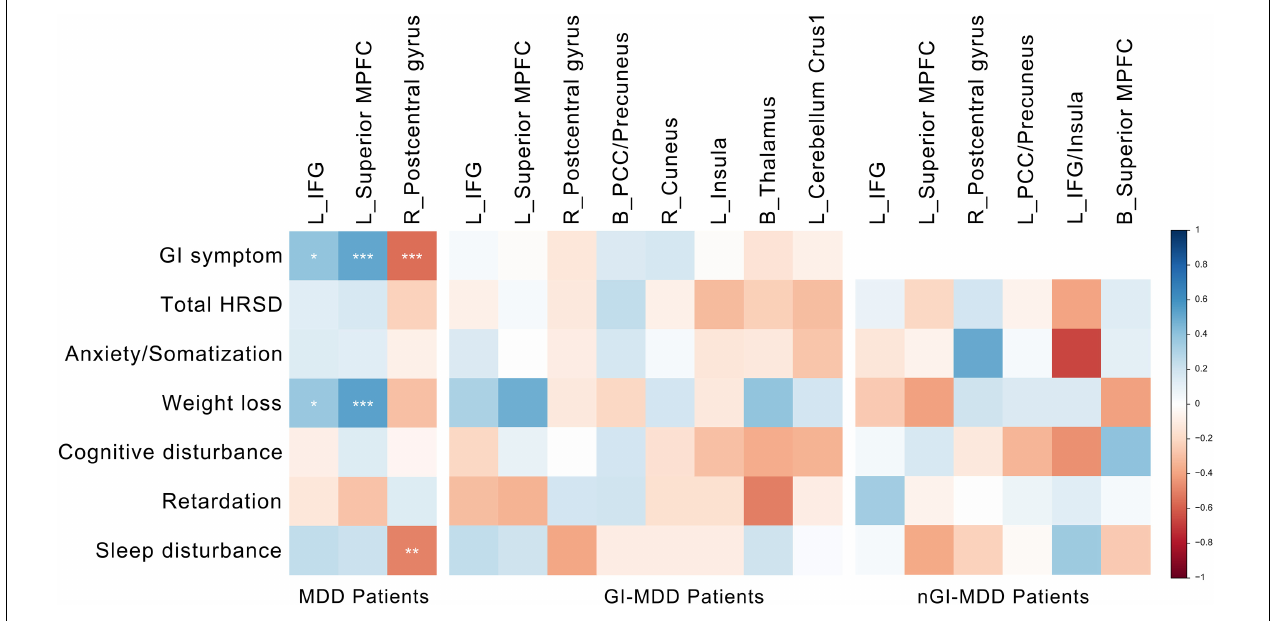
FIGURE 5 | Correlations between altered PAS scores and clinical variables. The color represents the Spearman correlation values. The significance levels are marked with asterisks (* p < 0.05, ** p < 0.01, *** p < 0.001). PAS, parameter of asymmetry.